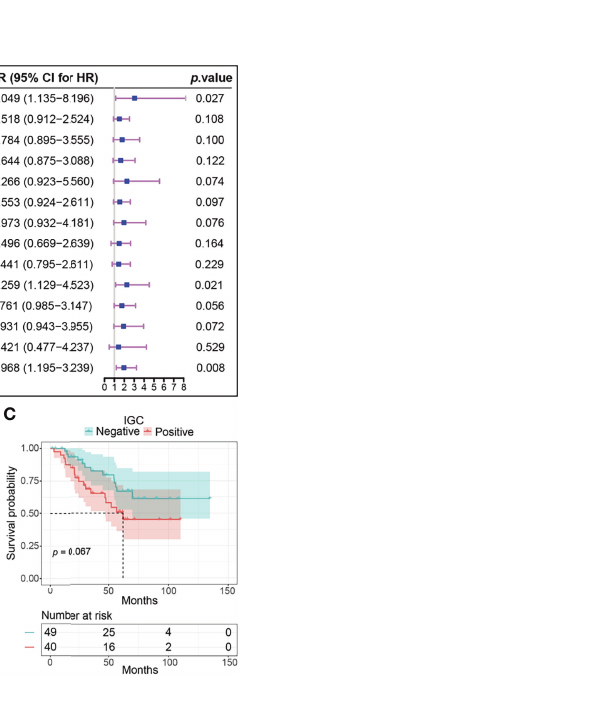
FIGURE 2 | The prognostic value of pFAK in subtypes of GC. (A) Results of survival analysis in different subgroups. HR and p value was calculated by univariate Cox regression. The reference level in each subgroup was negative pFAK. (B, C) Kaplan-Meier curves of pFAK-positive and pFAK-negative GCs in DGC subgroup (B) and IGC subgroup (C) . Log-rank test was used to calculate p value for Kaplan-Meier curves. The number of patients at risk are below the survival curve.